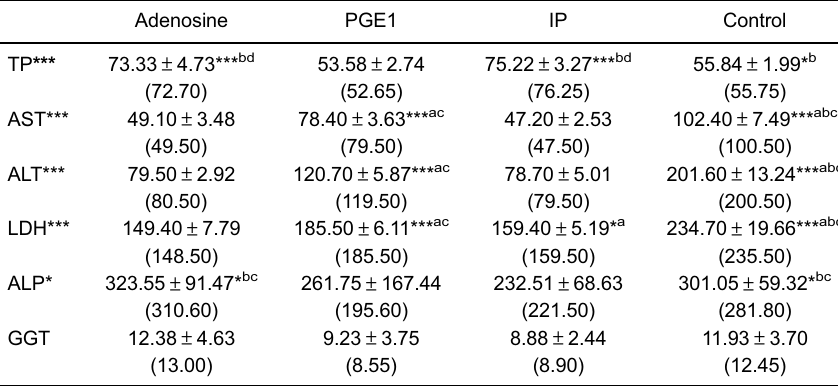
Table 1. Serum biochemical parameters of animals treated with ischemic preconditioning (IP), adenosine and prostaglandin E1 (PGE1) in the experimental model of hepatic ischemia/ reperfusion